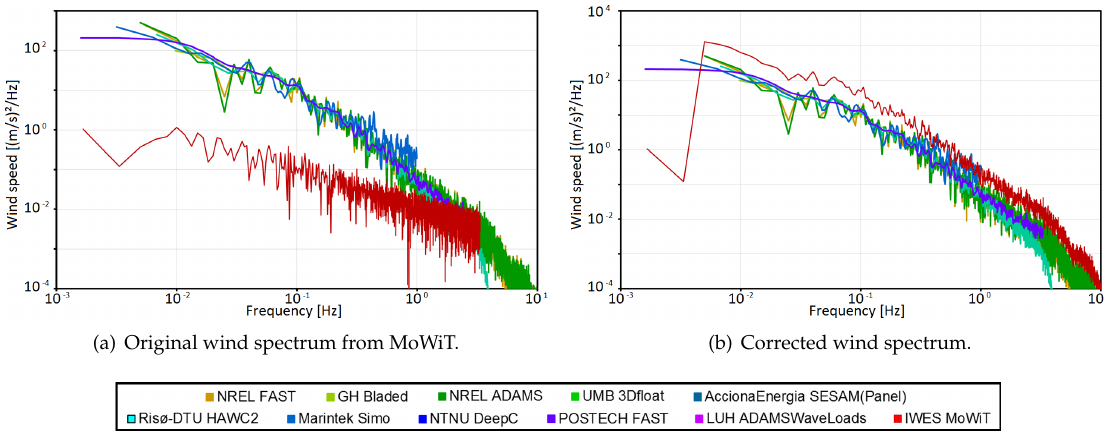
Figure 21. Wind power spectra for LC 5.3 in